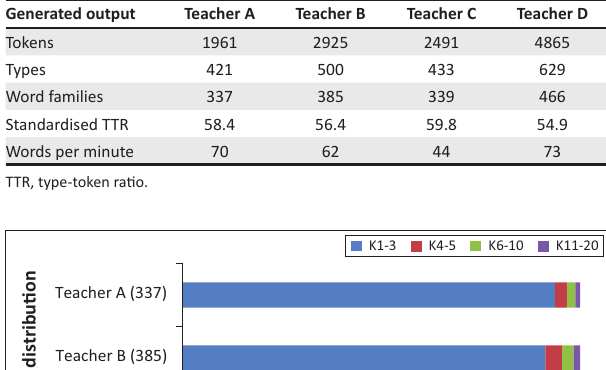
TABLE 5: Overview of word frequencies in teacher talk. Generated output